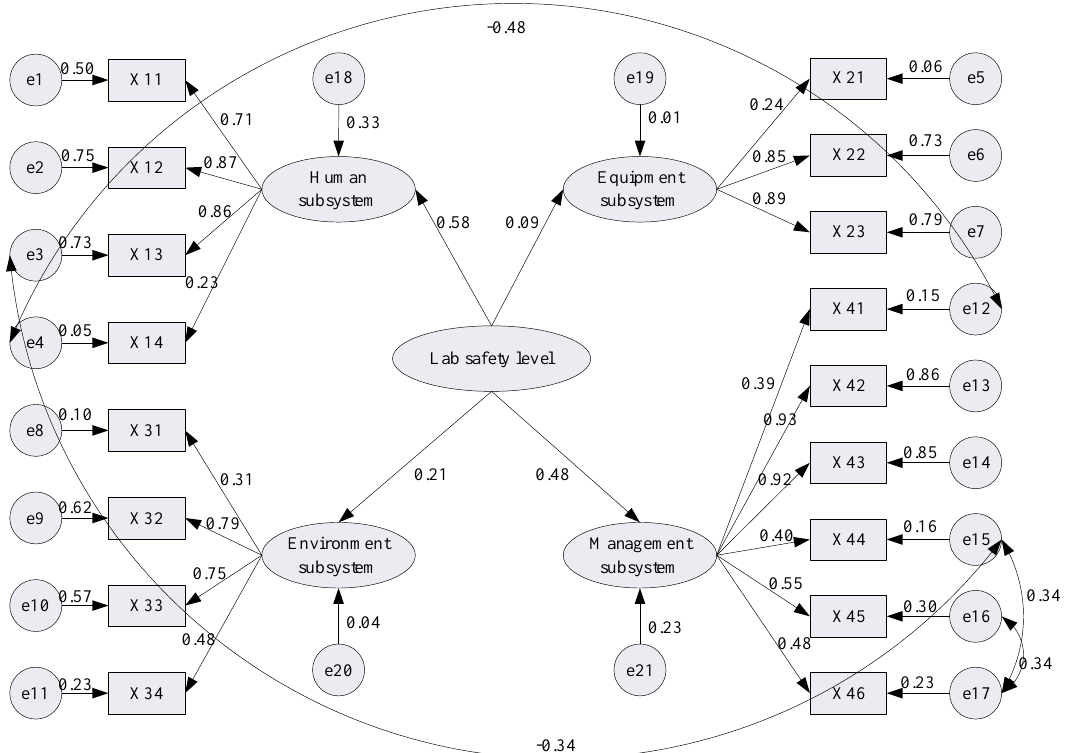
Figure 4. Standardized estimation results of the modified SEM. Table 7. Modified SEM fit results.